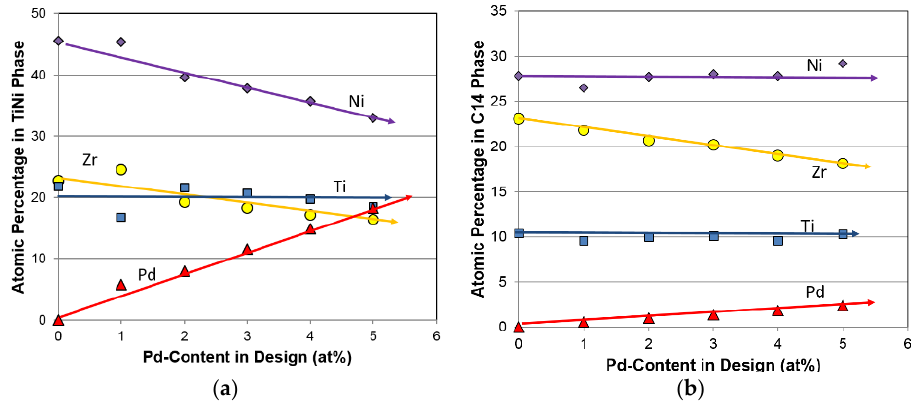
Figure 5. Evolution of the contents of the major constituting elements in the ( a ) TiNi and ( b ) C14 phases with increasing Pd-content in design.